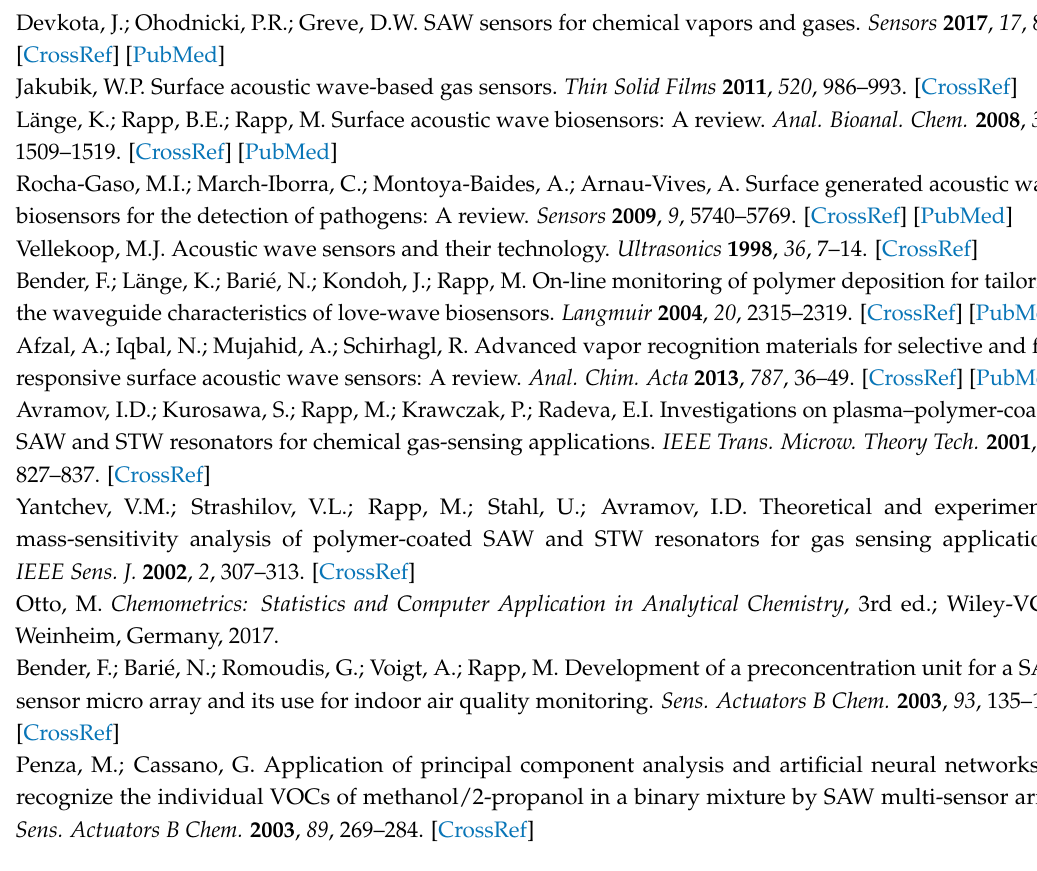
Table S1: Difference frequency shifts obtained with the STW sensor array, Table S2: Normalized difference frequency shifts obtained with the STW sensor